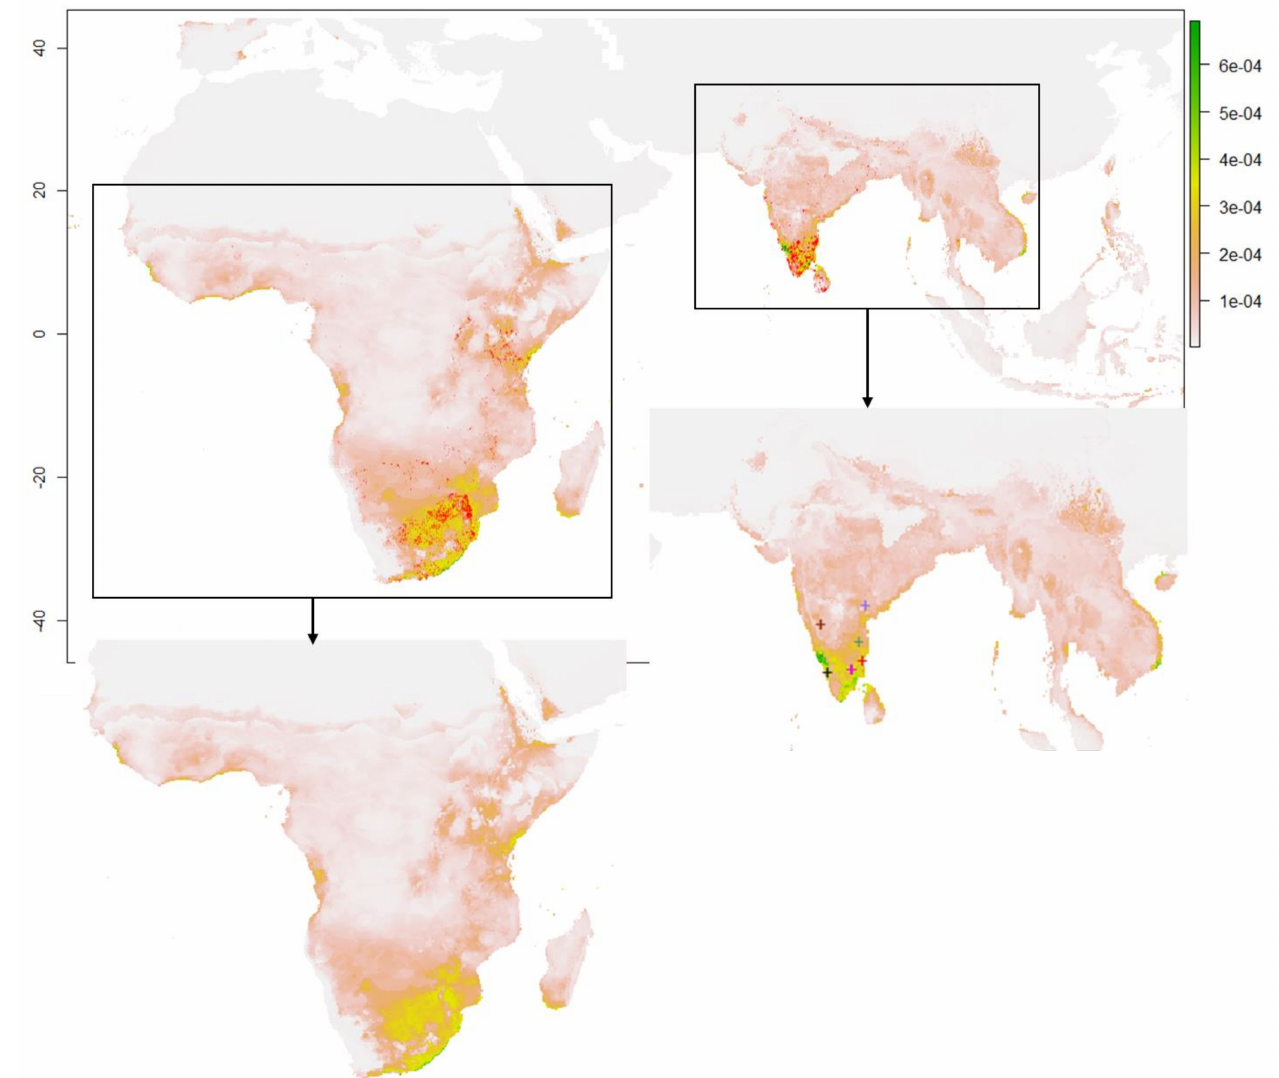
Figure 7. Current habitat suitability predictions of October-December for the Jacobin cuckoo range. The regions marked with a cross sign in the lower right part of the figure are: Andhra Pradesh (blue mark), mainly in the coastal regions, Kerala (black mark), Puducherry (red mark), Rayalaseema (green mark), South Karnataka (marron mark) and Tamil Nadu (pink